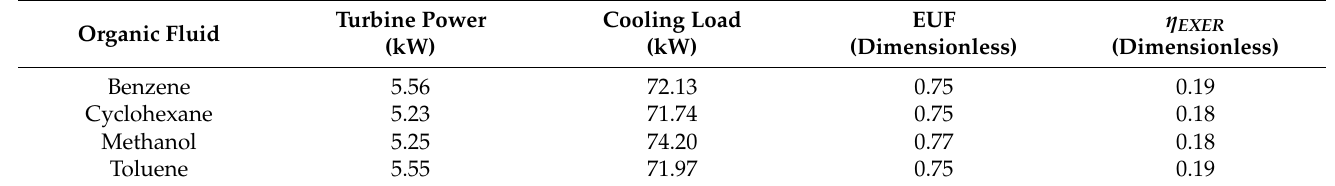
Table 11. Comparison of the main parameters for the different working fluids at one selected operating